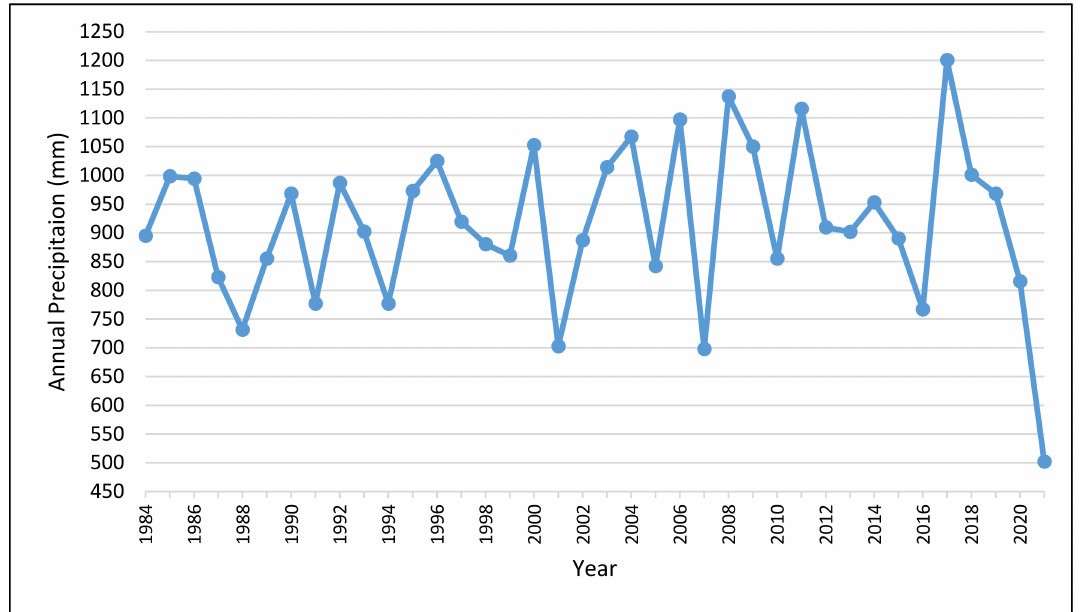
Figure 17. Total annual precipitation data for Prince Edward County (Trenton station) since 1984. Adopted from